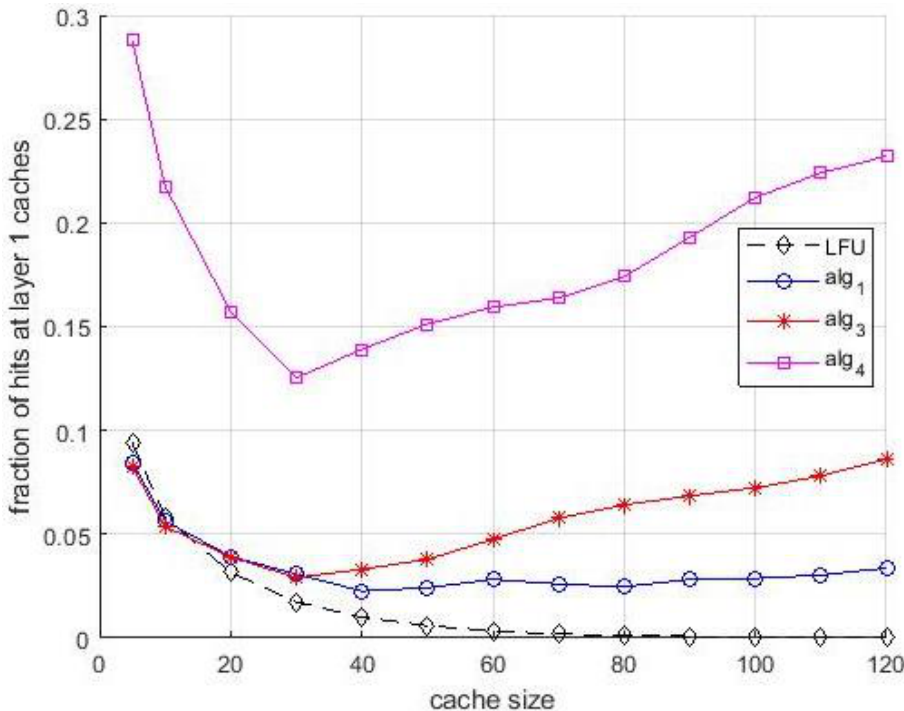
Figure 8. Fraction of hits at 1st layer caches, case 2, N =